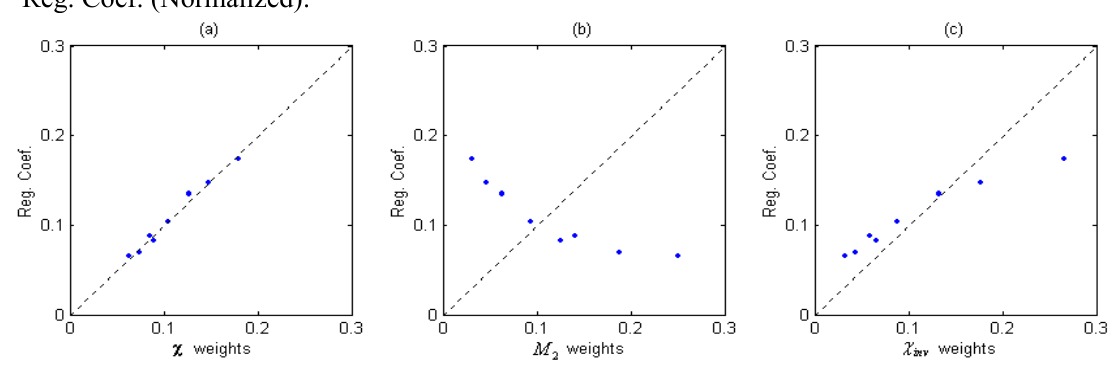
weights vs. Reg. Coef. and (c) χ inv weights vs. 2